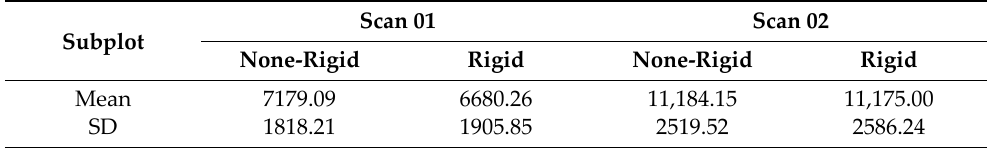
Table 3. Mean and standard deviation (SD) of HLS point cloud density (expressed in point per m 2 ) for each of the four scans tested (Scan 01 and Scan 02 under the rigid and none‑rigid transformation mode,